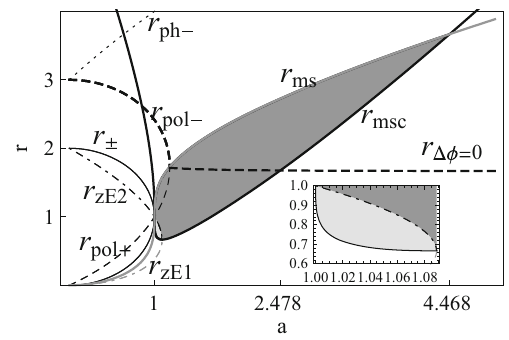
Fig. 21 Relative position of the equatorial circular orbits of the test particles and the spherical photon orbits. The overlap region of the stable circular orbits of test particles and stable photon spherical orbits is highlighted in grey, the light grey shading correspond to radii of the circular orbits with negative energy. The function r (cid:4)φ = 0 (bold dashed curve) corresponds to radii of the closed spherical photon orbits with zero total change in azimuth (cid:4)φ = 0 . It interferes with the area of possible occurrence of the thin Keplerian accretion disc, hence, some self-illumination effects manifesting itself as periodic light echo are plausible here. The remaining functions are defined in the